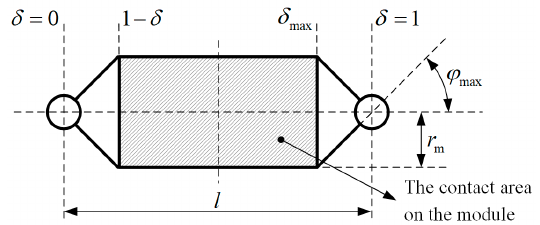
Figure 8. The parameters of a single joint module.